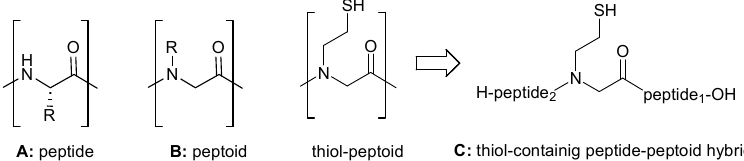
Figure 1. Comparison of a peptide ( A ), a peptoid ( B ), and the newly synthesized thiol-containing peptide–peptoid structure ( C ).